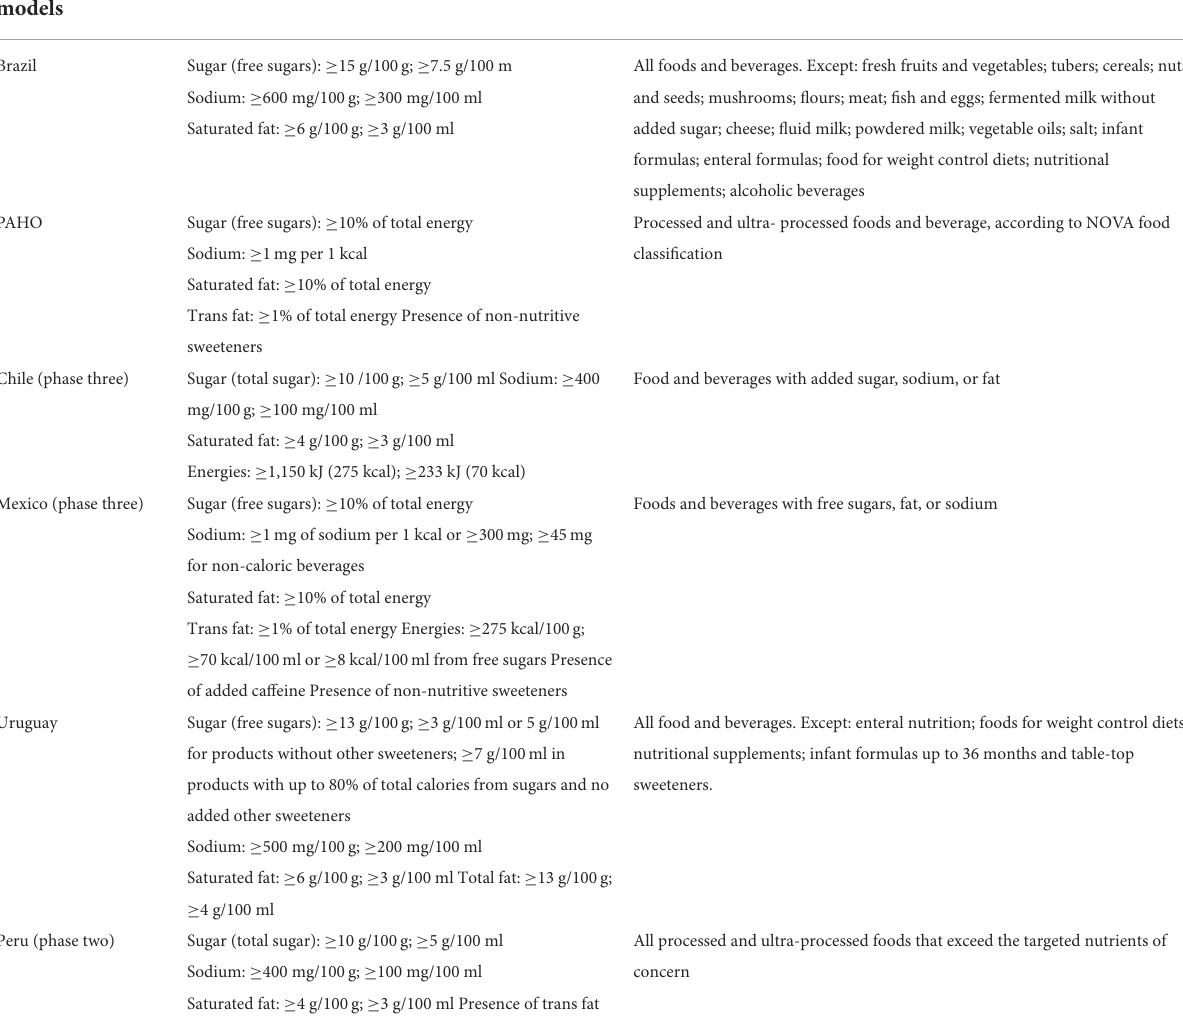
TABLE 1 Characteristics of the six nutrient profiling models used in this